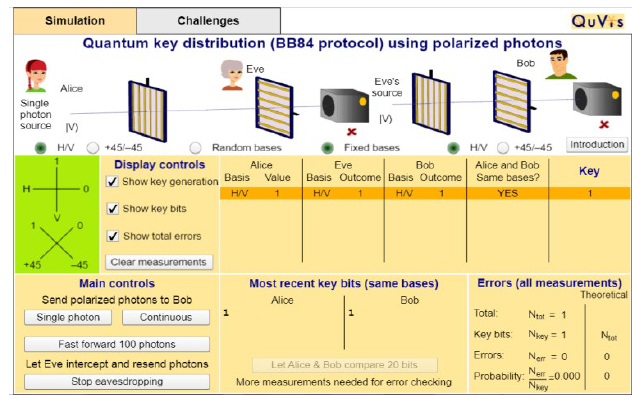
Figure 3. Session not captured but data